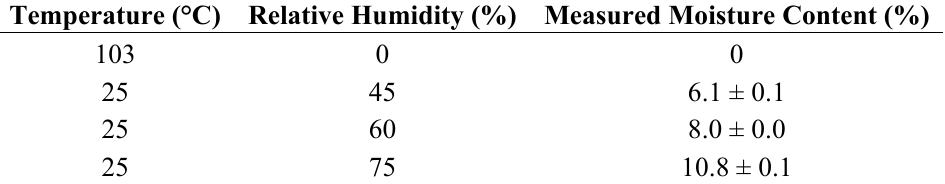
Table 2. Moisture content of α -cellulose samples obtained from equilibrium (2 weeks) at different relative humidity.